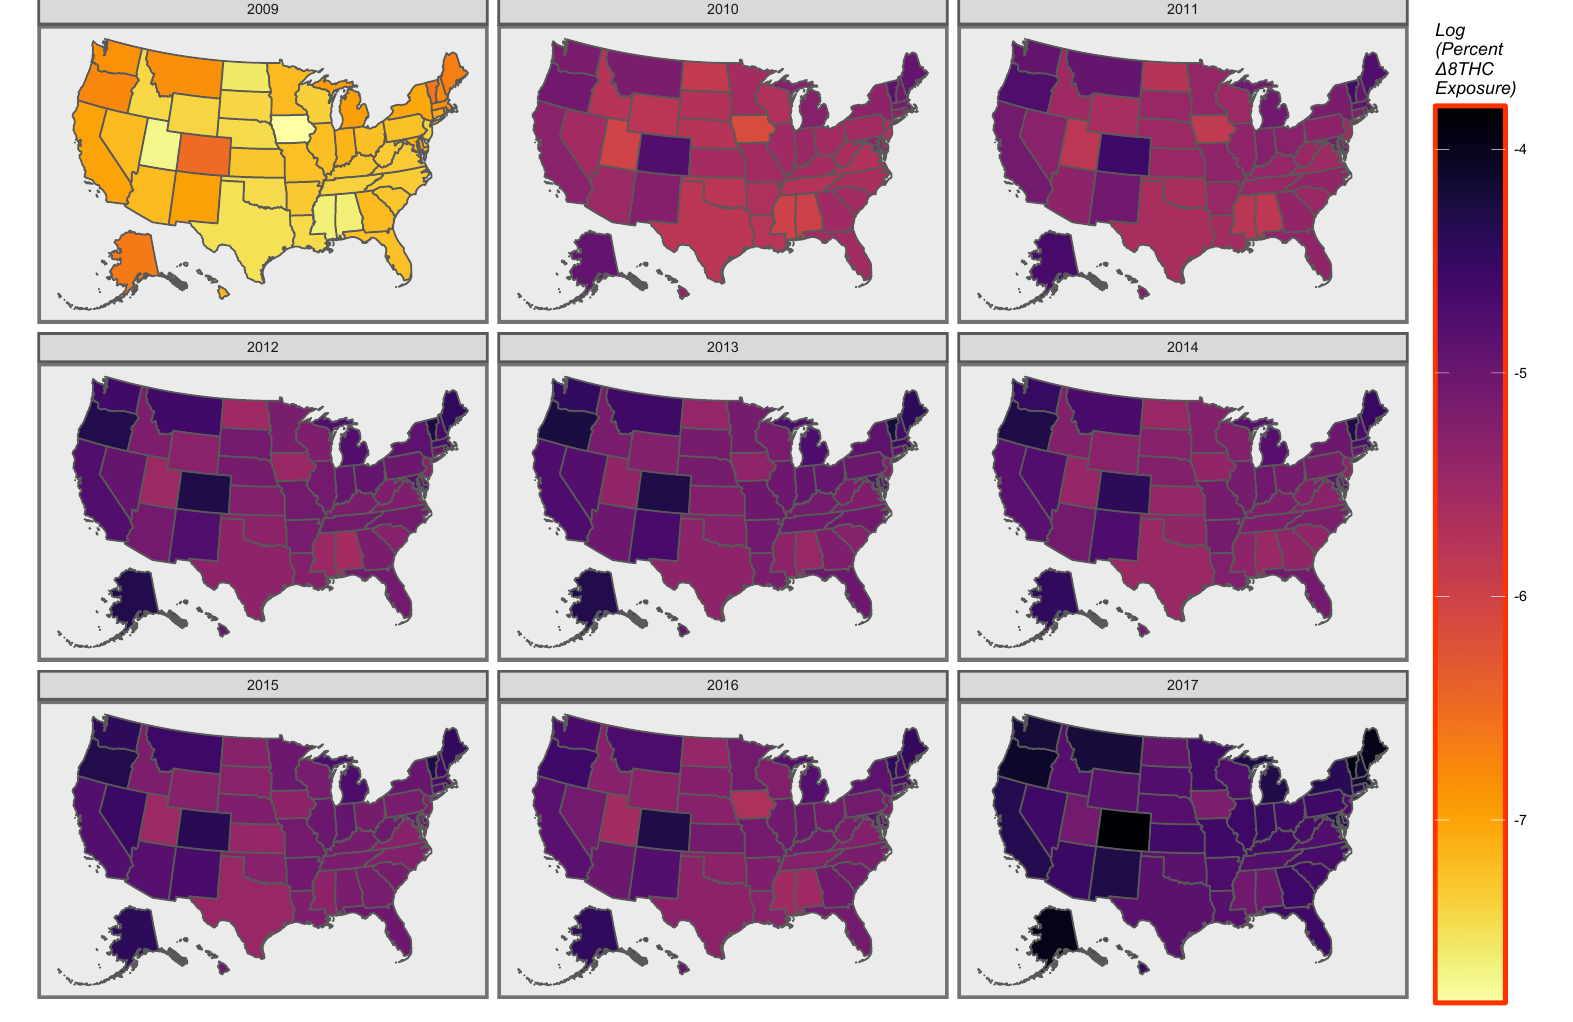
Figure 1. Map of the log ( ∆ 8THC estimates) across the USA over